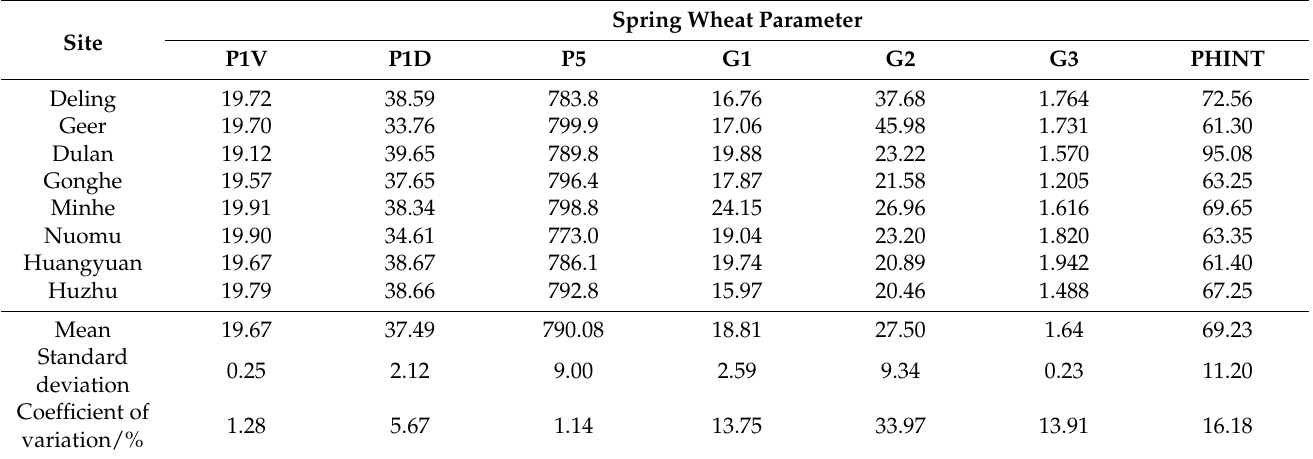
Table 3. Genetic coefficients of spring wheat at the selected 8